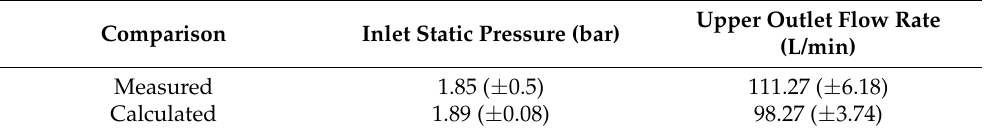
Figure 7. Comparison of calculated and measured results; ( a ) inlet static pressure and ( b ) upper outlet flow rate. Table 4. Averaged values obtained by measuring and calculating.